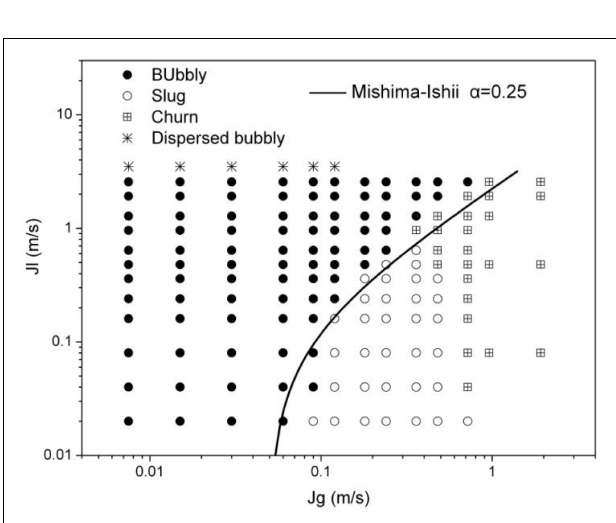
FIGURE 10 | Comparison between Mishima-Ishii criterion and experimental results.